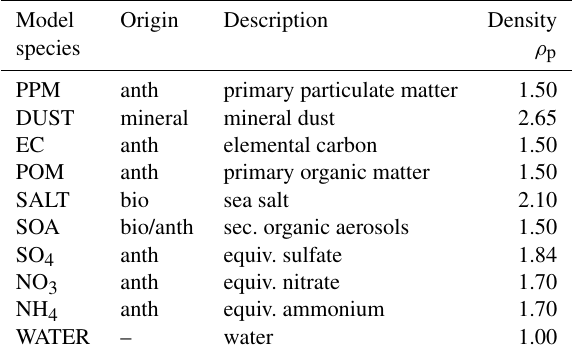
Table 3. Properties of the modeled aerosol species. The density ρ p is expressed as value × 10 3 kgm − 3 . “anth”, “bio” and “mineral” refer to the origin of the emission, respectively anthropogenic, bio- genic and mineral dust.